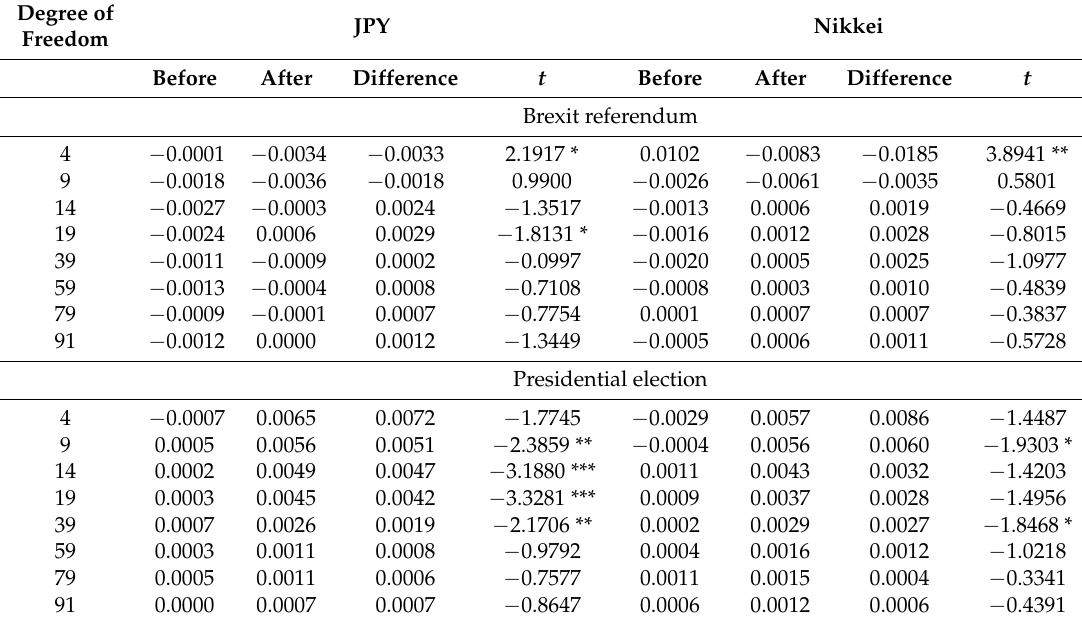
Table 2. One sample t